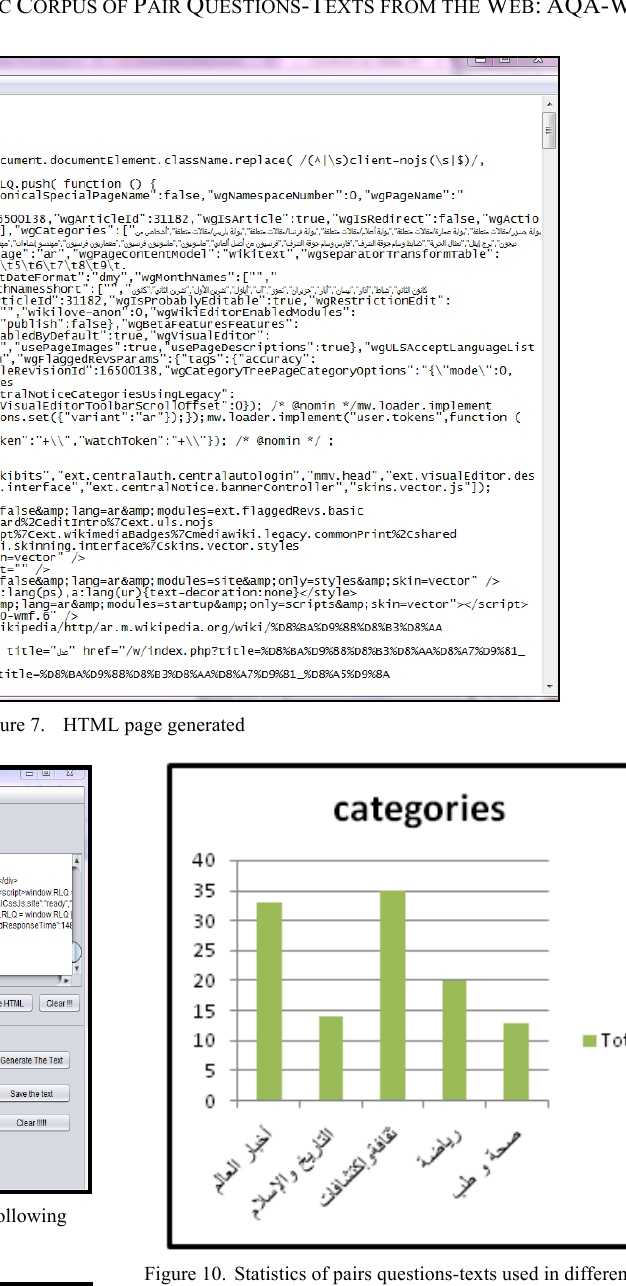
Figure 10. Statistics of pairs questions-texts used in different